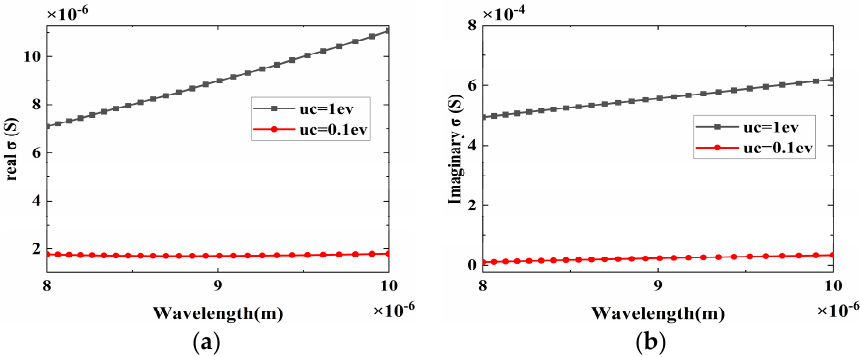
Figure 2. Real part ( a ) and imaginary part ( b ) of graphene surface conductivity as a function of chemical potential at 8 μ m < λ < 10 μ m.